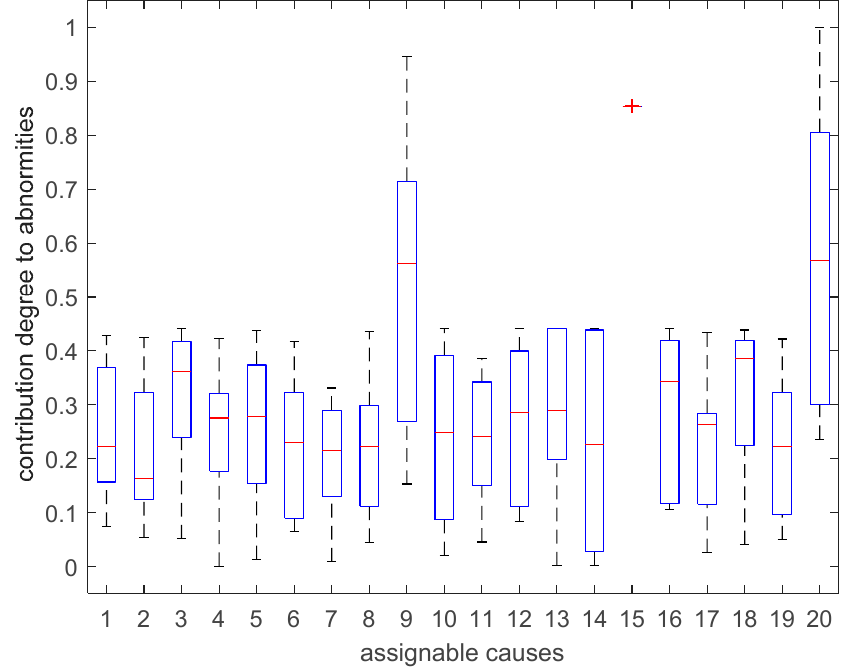
Figure 8. Boxplot of Interval solution of causes membership degree.